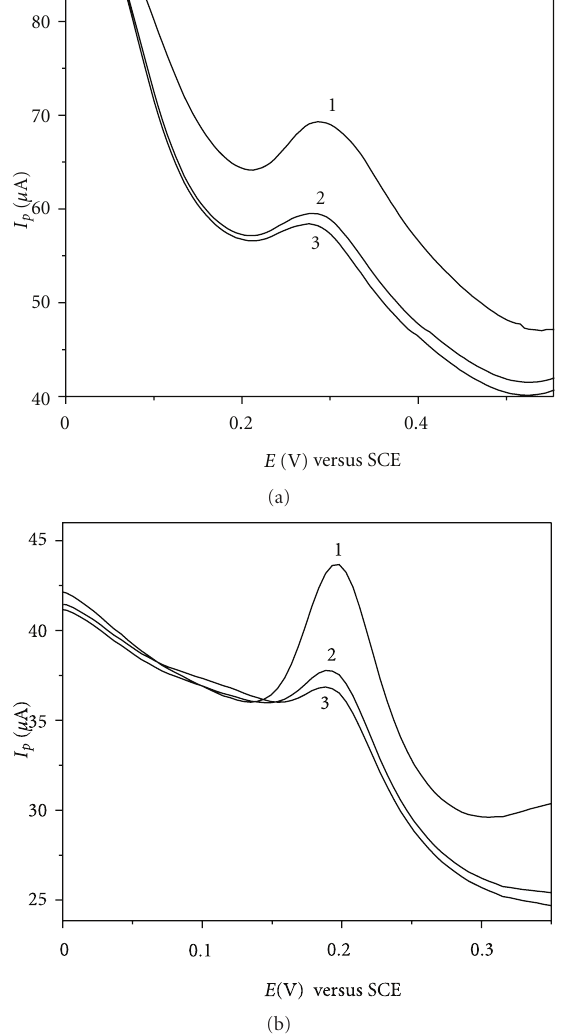
Figure 3: (1) First cycle, (2) second cycle, and (3) third cycle of the anodic responses of 1 × 10 − 4 M (a) CD and (b) BS from repetitive voltammograms in 0.1M PBS at pH 5.0 with MWCNTs/PNB- modified electrode. Scan rate 50 mVs − 1 .